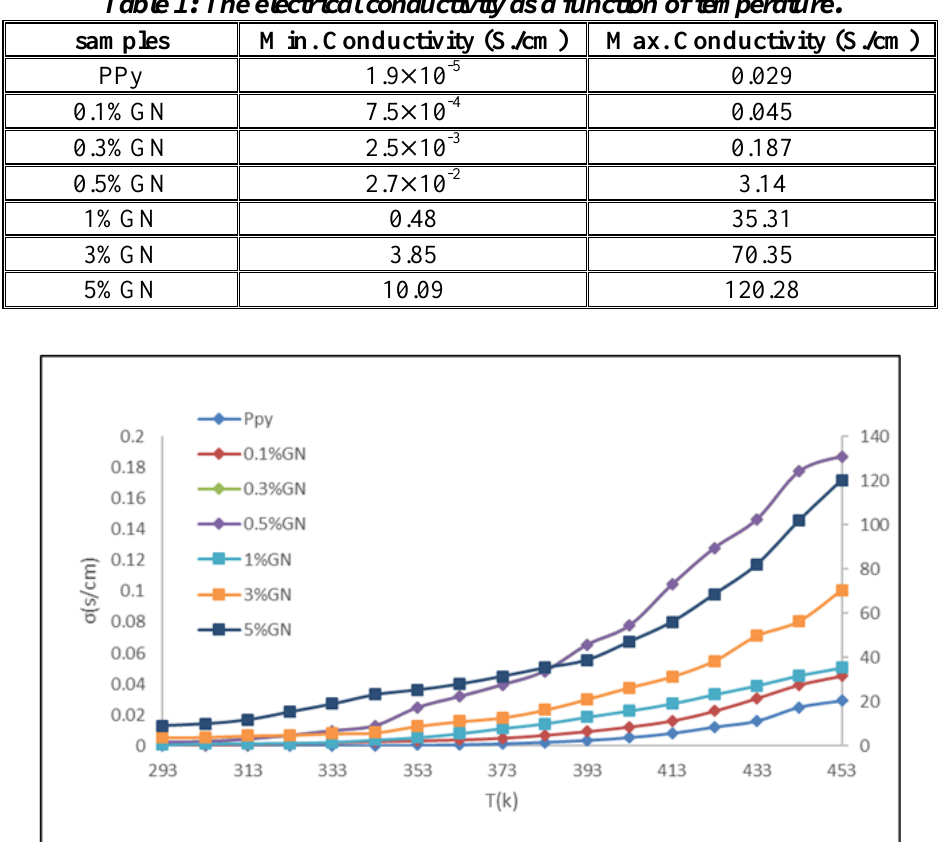
Fig.10: The D.C electrical conductivity with temperature for PPy/GN